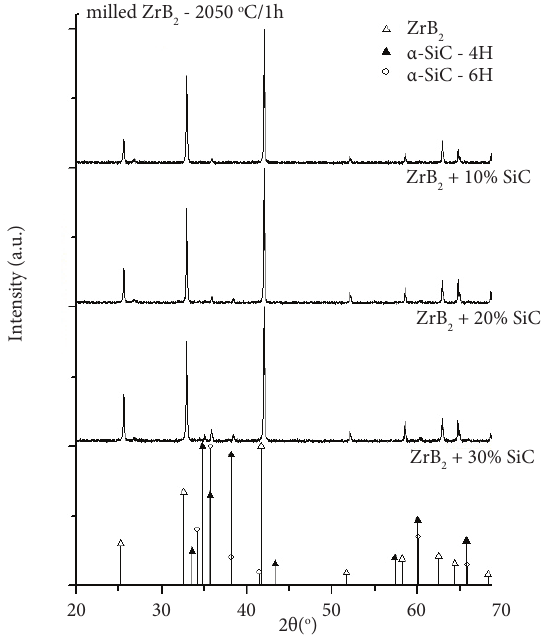
Figure 5. XRD patterns of the MZ-SiC composites after sintering at 2050